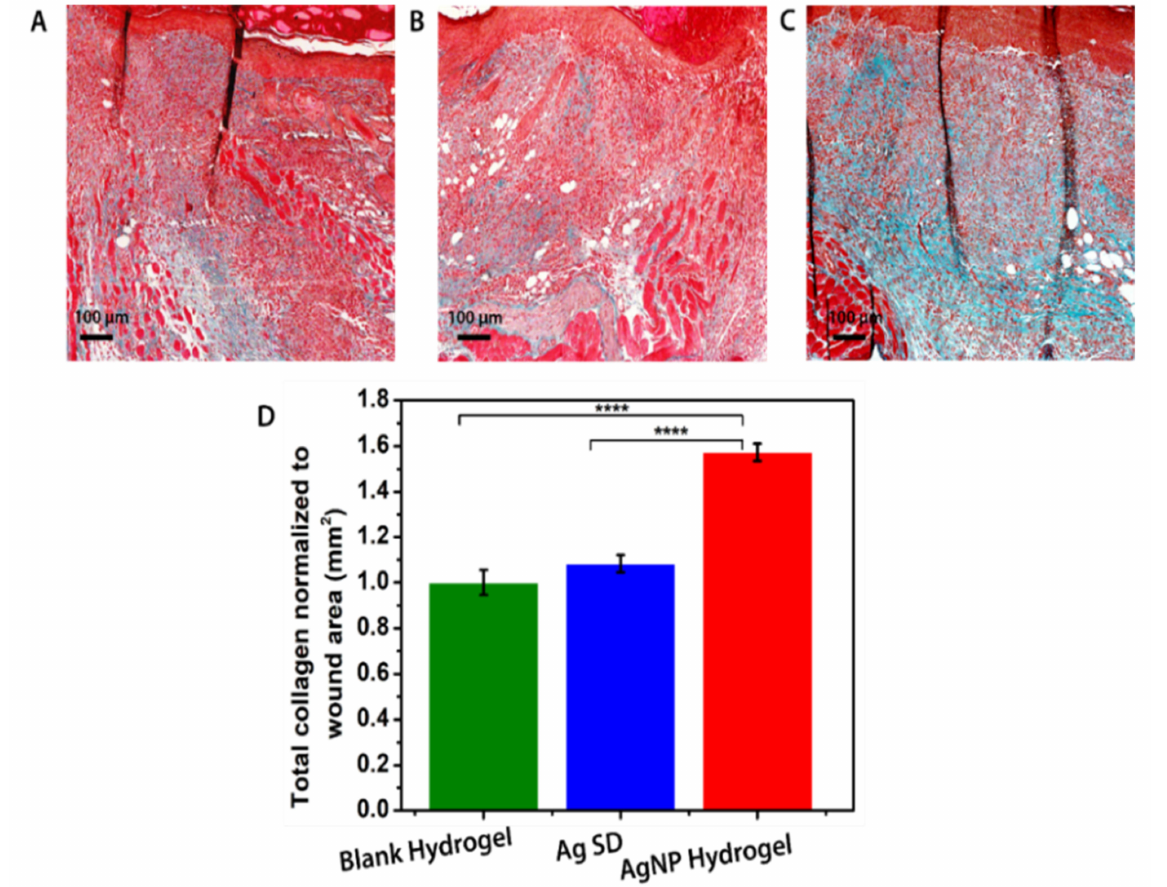
Figure 8. Masson’s trichrome staining of the wound sections showing collagen deposition after treatment for 10 days. ( A – C ) Images of Masson’s trichrome stained wound tissues of blank hydrogel, Ag SD, and AgNP hydrogel displaying collagen distribution and arrangements. ( D ) Quantitative analysis of total collagen content detected normalized to the respective wound area (mm 2 ). Data are shown as mean ± SD and the * denotes significant difference using one-way ANOVA followed by Dunnett’s multiple comparison test. **** p < 0.0001, n =